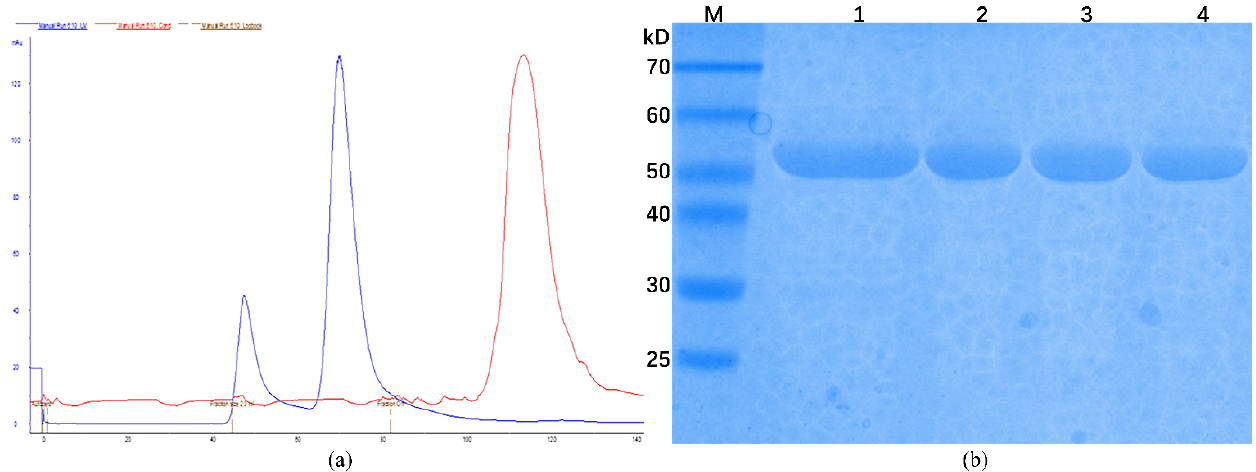
Figure 2. Protein purification of C Las GMPS. ( a ) Analysis of C Las GMPS with SEC; ( b ) SDS-PAGE analysis of C Las GMPS after purification; M: Protein marker; 1: Sample of affinity chromatography; 2–4: Sample of SEC.